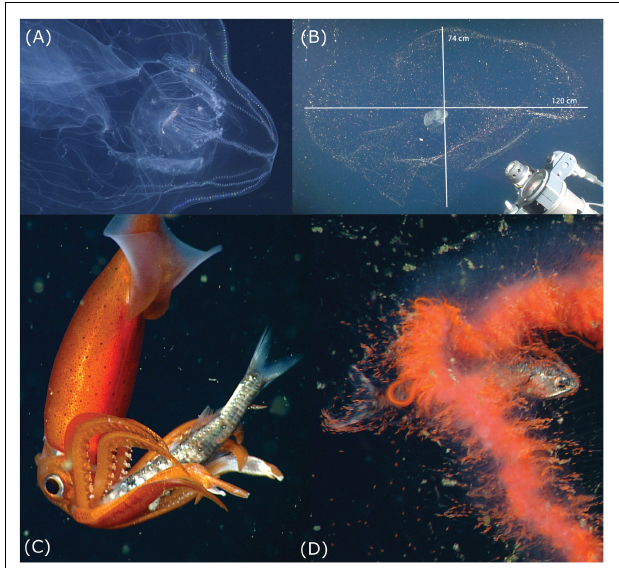
FIGURE 3 | Potential threats to vertical migrators. Note that the images are not at the same scale. (A) The ctenophore Thalassocalyce has trapped a euphausiid krill within its lobes and is slowly transporting the prey using ciliary action, toward its mouth. This predator uses its transparent lobes to intercept vertically migrating prey. (B) The mucus “house” of the giant larvacean Bathochordaeus stygius, which can present an obstacle for vertically migrating zooplankton and micronekton, often spans > 1 m in greatest dimension. The outer structure is a coarse-mesh filter and the inner portion is a fine-mesh filter within which the animal sits. When the filters become clogged, the larvacean discards them and extrudes another house. Precise measurements of structures too large and fragile to collect can be made with Deep-PIV (Katija et al., 2017) seen in the lower right corner. (C) The squid Gonatus onyx is holding a myctophid fish, Stenobrachius leucopsarus, with its arms, after catching it with long feeding tentacles. The squid disables the fish, using its beak to sever the spinal cord. (D) This undescribed, orange, physonect siphonophore has captured a myctophid fish, S. leucopsarus, with its tentacles and is maneuvering the prey into a gastrozooid (stomach). Access to additional data on these and other predators and prey is available through the MBARI Deep-Sea Guide: